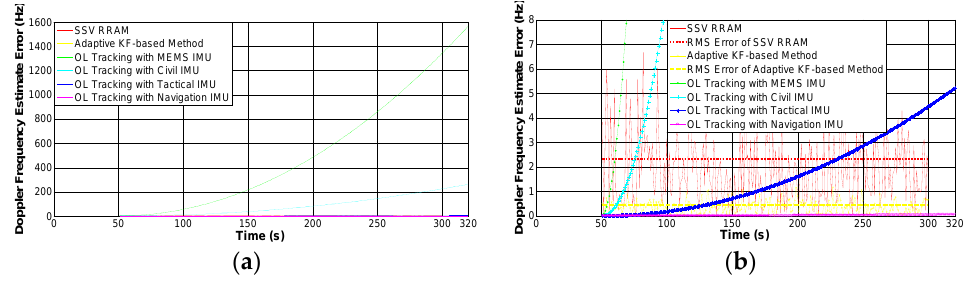
Figure 10. Comparison of Doppler estimation errors using different tracking schemes in the experiments. ( a ) Global view; and ( b ) close-up view.